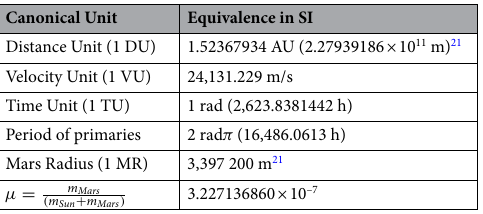
Table 1. Equivalence of the Non-dimensional Units Sun-Mars to